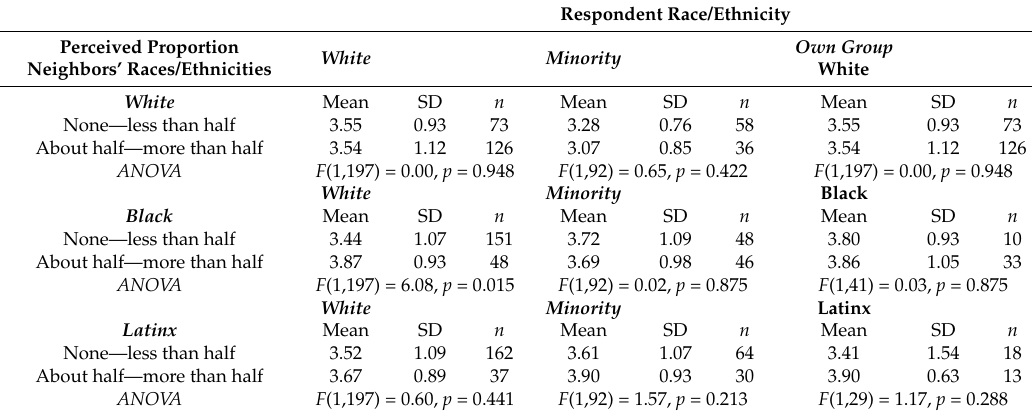
Table A2. Support for redistribution (Index 1) by perceived neighborhood ethnic composition and respondent